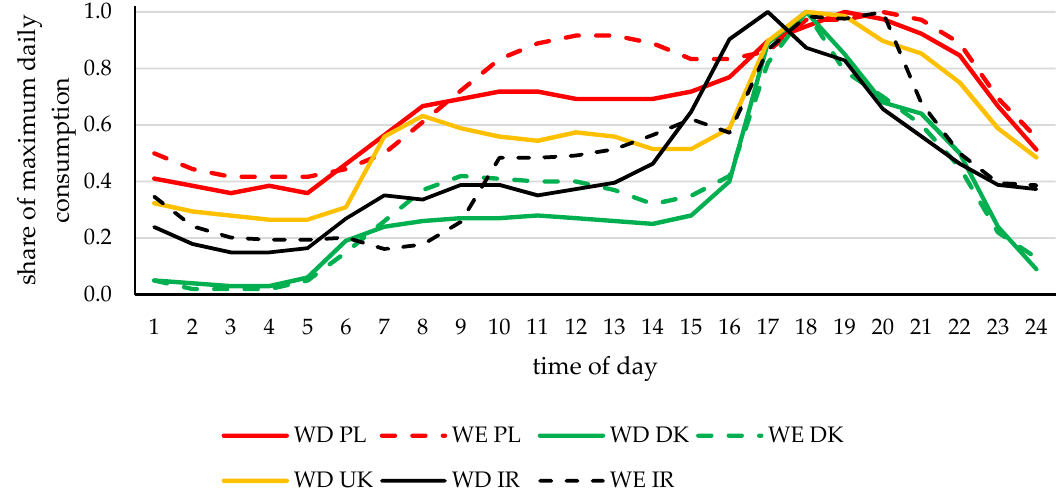
0.00.20.40.60.81.0 Figure 3. Average daily electricity load profile normalized on the individual maximum of each load profile: WD PL—weekdays Poland; WE PL—weekend Poland; DK—Denmark; UK—United Kingdom; IR—Ireland. Source: own study based on [57–60]. Figure 4. Map of Poland with degree–day values for each voivodship (color scale: dd15, black color) and the percentage share of the number of households in the voivodship in relation to the total for the whole country (shp—blue color). The location of the analyzed building is also marked (AB).